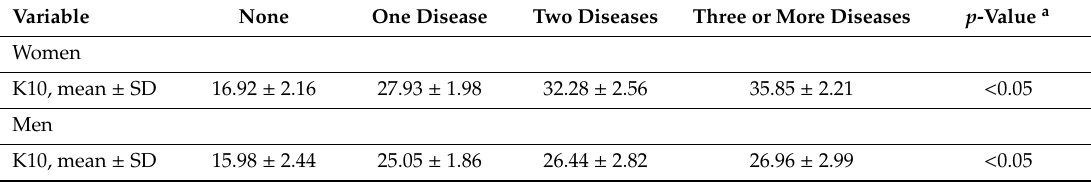
Table 2. Comparisons of K10 scores between categories of multimorbidity status ( n = 936).